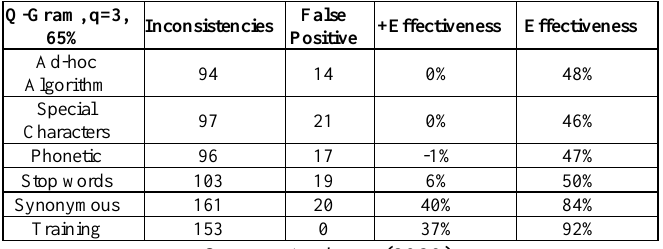
Table 7: Results obtained with data cleaning process using the algorithm Q-Grams, with q=3 and 65% similarity.